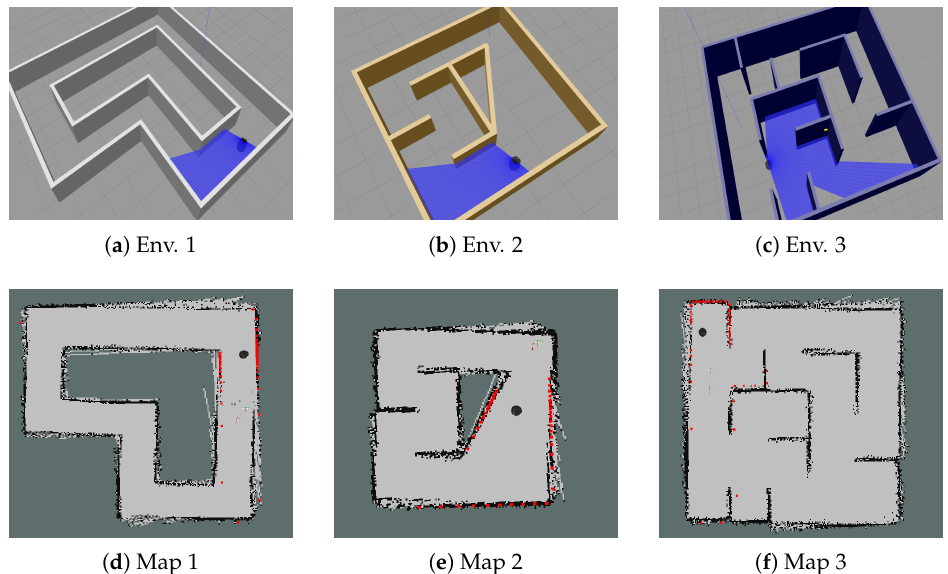
Figure 1. Gazebo simulation environments (top) and their corresponding maps generated by the SLAM algorithm (bottom).